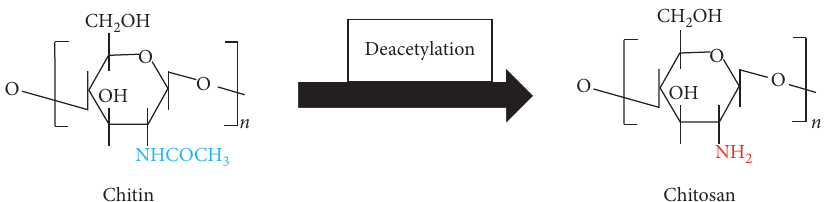
Figure 2: Structural representation of the deacetylation reaction producing